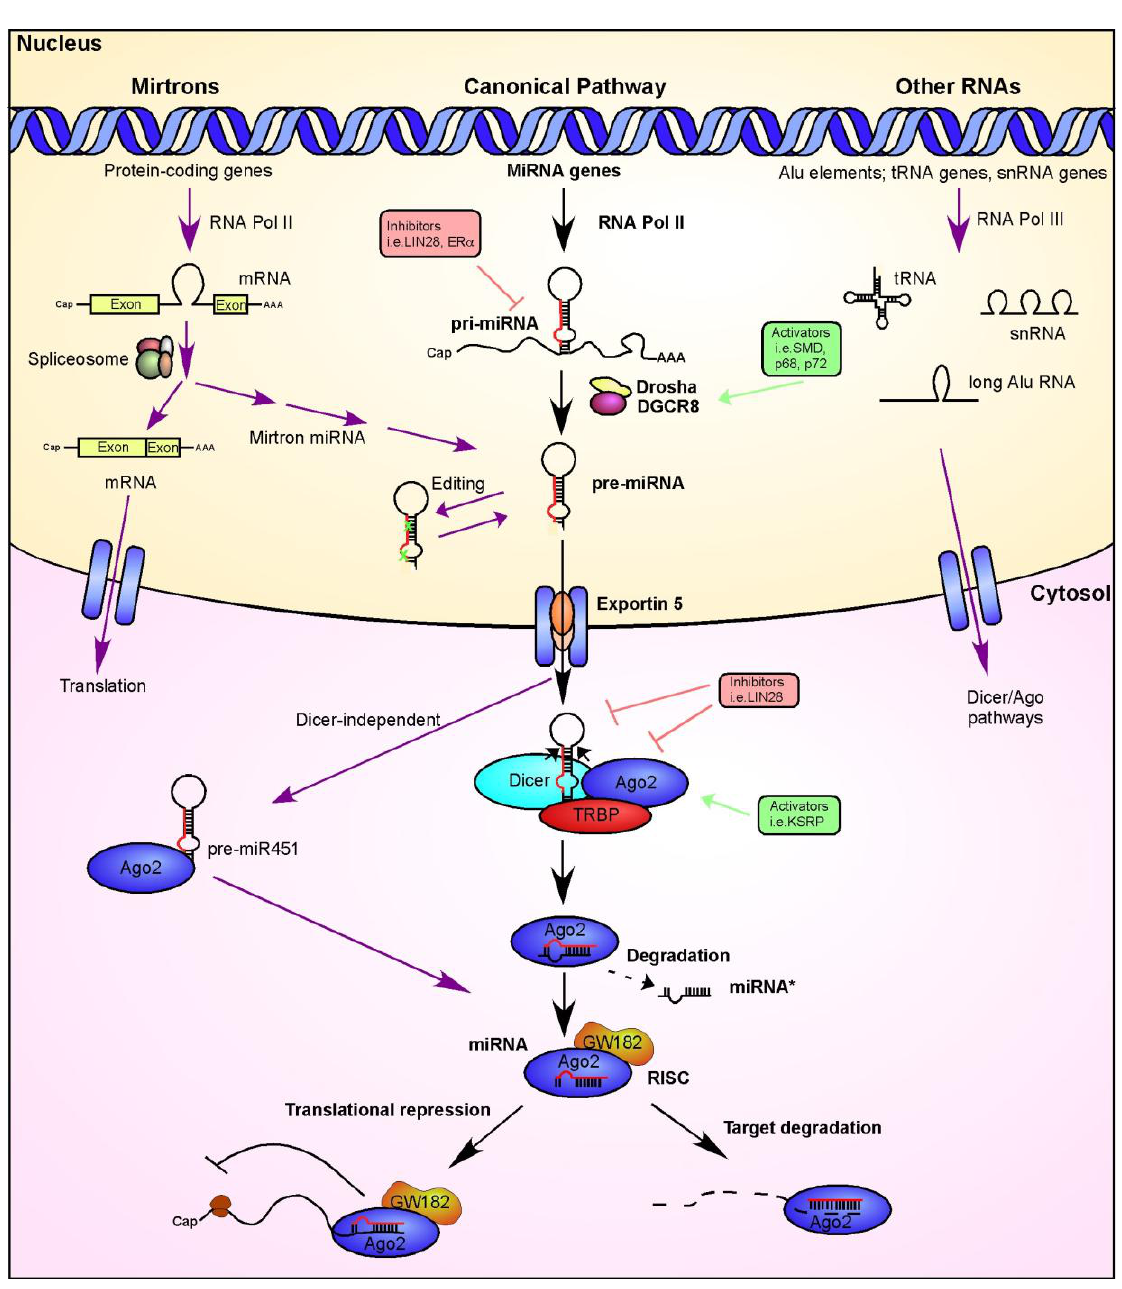
Figure 1. MicroRNA biogenesis